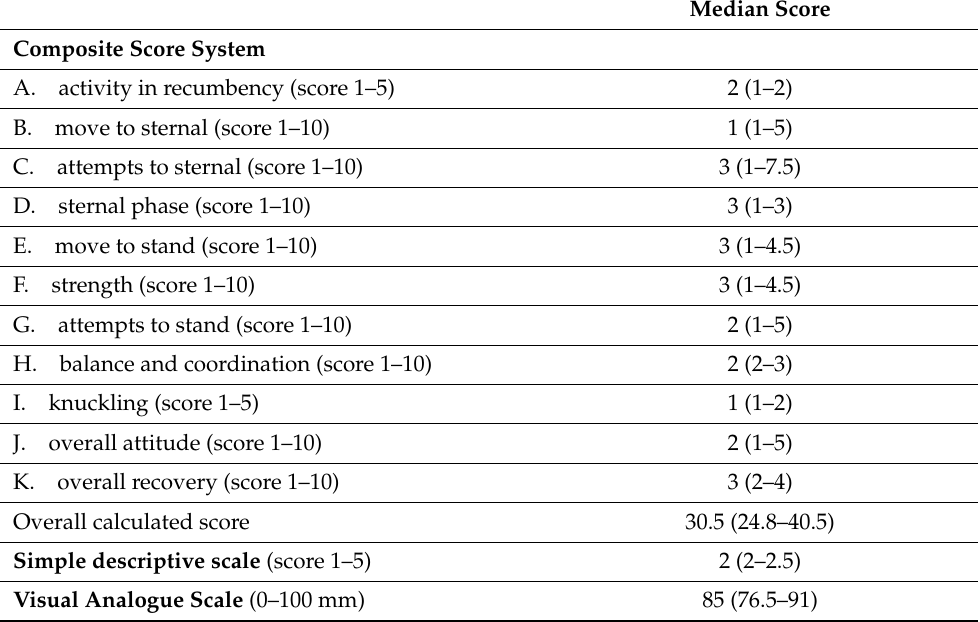
Table 3. Anaesthetic recovery scores using a Composite Score System, Simple Descriptive Scale and Visual Analogue Scale for five colts anaesthetised for 40 min with infusions of ketamine, medetomi- dine and midazolam as part of a balanced anaesthetic technique for surgical